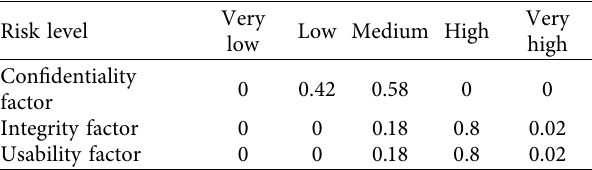
Table 3: Fuzzy matrix of asset risk.